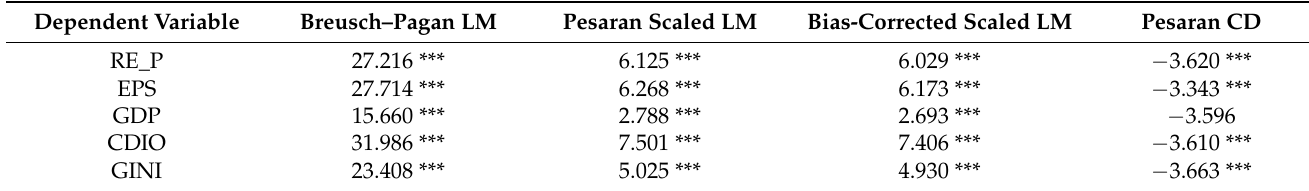
Table 3. Cross-sectional dependency (CD) test for model 1.